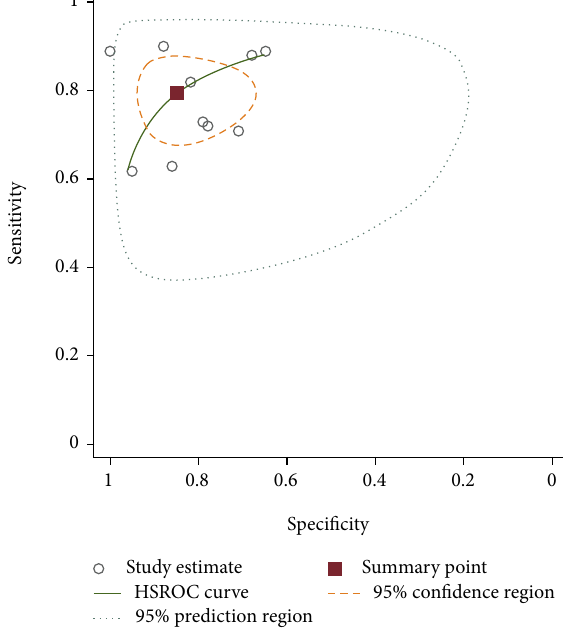
Figure 4: SROC curve of included studies assessing diagnostic value of NLR for AT.